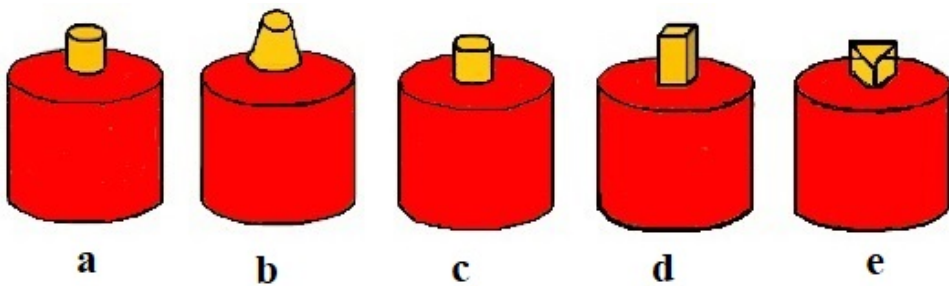
Figure 1. Different profiles of cylindrical FSW tools with ( a ) straight, ( b ) tapered, ( c ) threaded, ( d ) square, and ( e ) triangular pins.